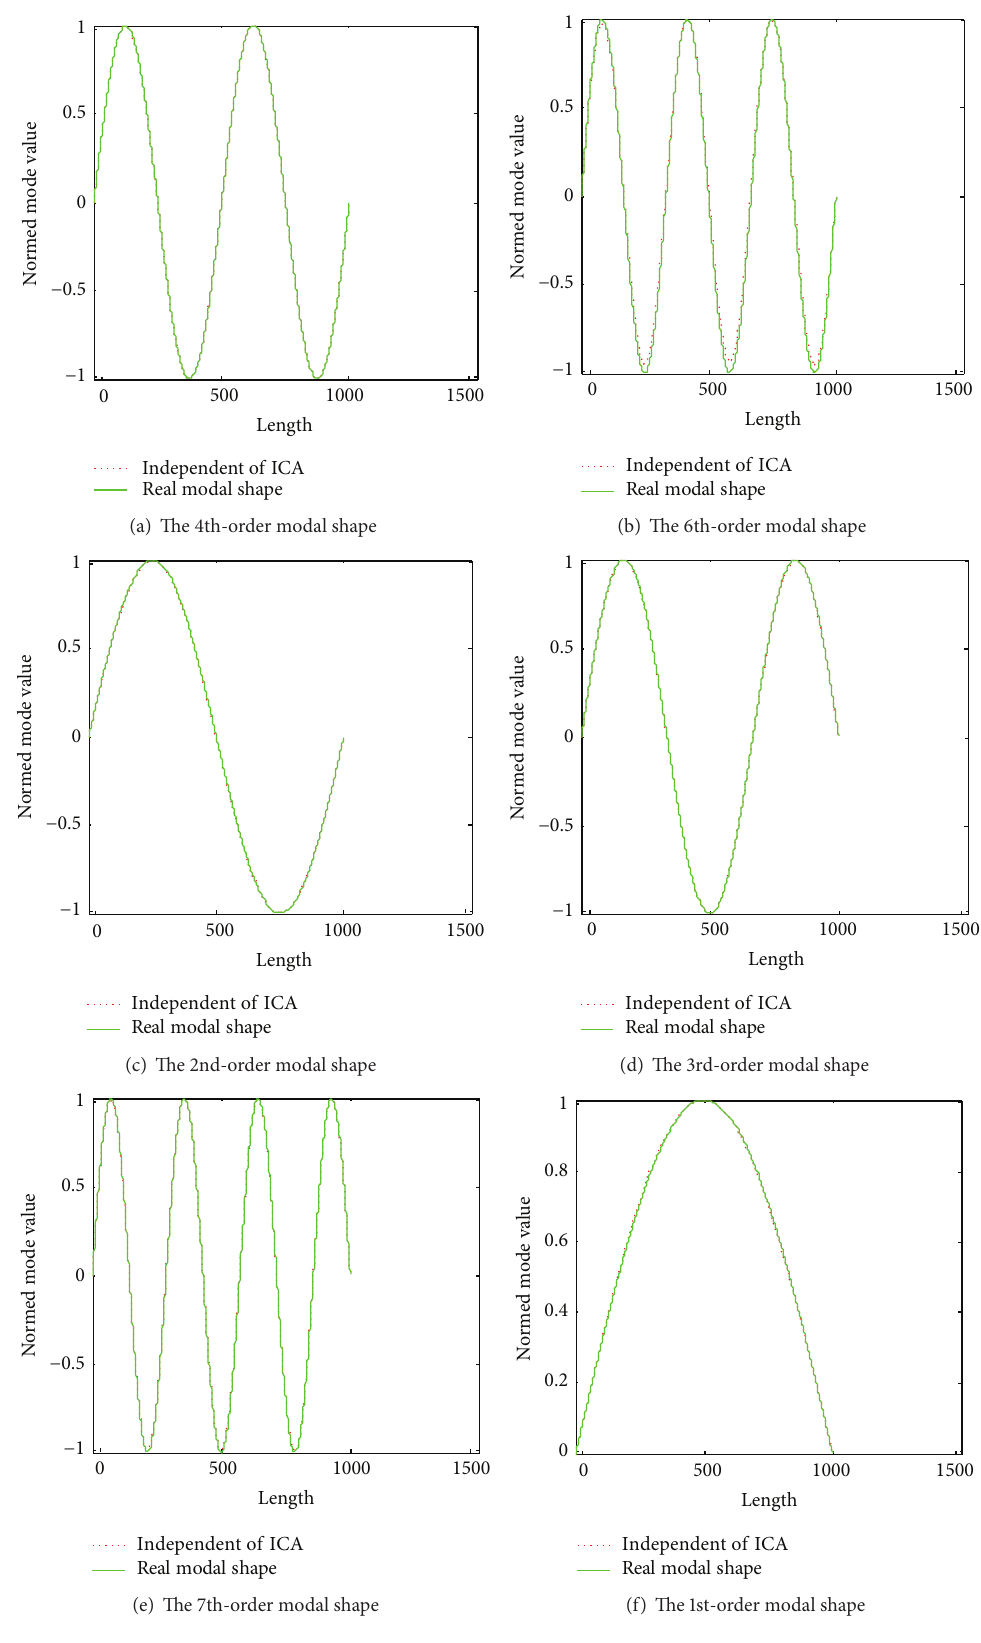
Figure 6: Modal shape comparison between FEA and separating vector by maximization negentropy with